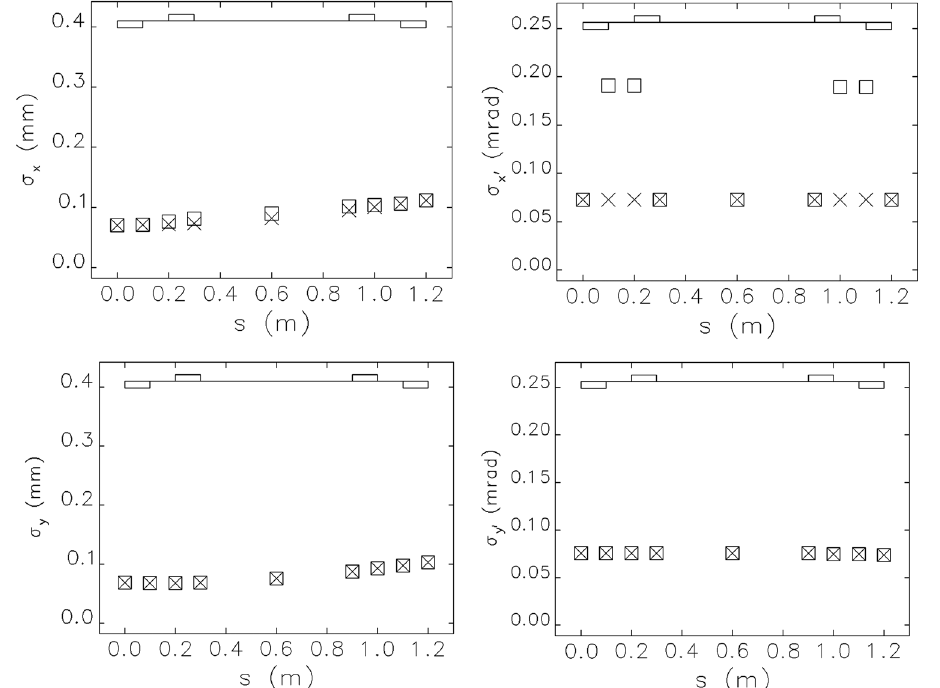
FIG. 16. Top left: rms horizontal beam size along NIEM with (squares) and without (crosses) energy spread. Top right: rms horizontal angular spread in mrad along NIEM with (squares) and without (crosses) energy spread. Bottom left: rms vertical beam size. Bottom right: rms vertical angular